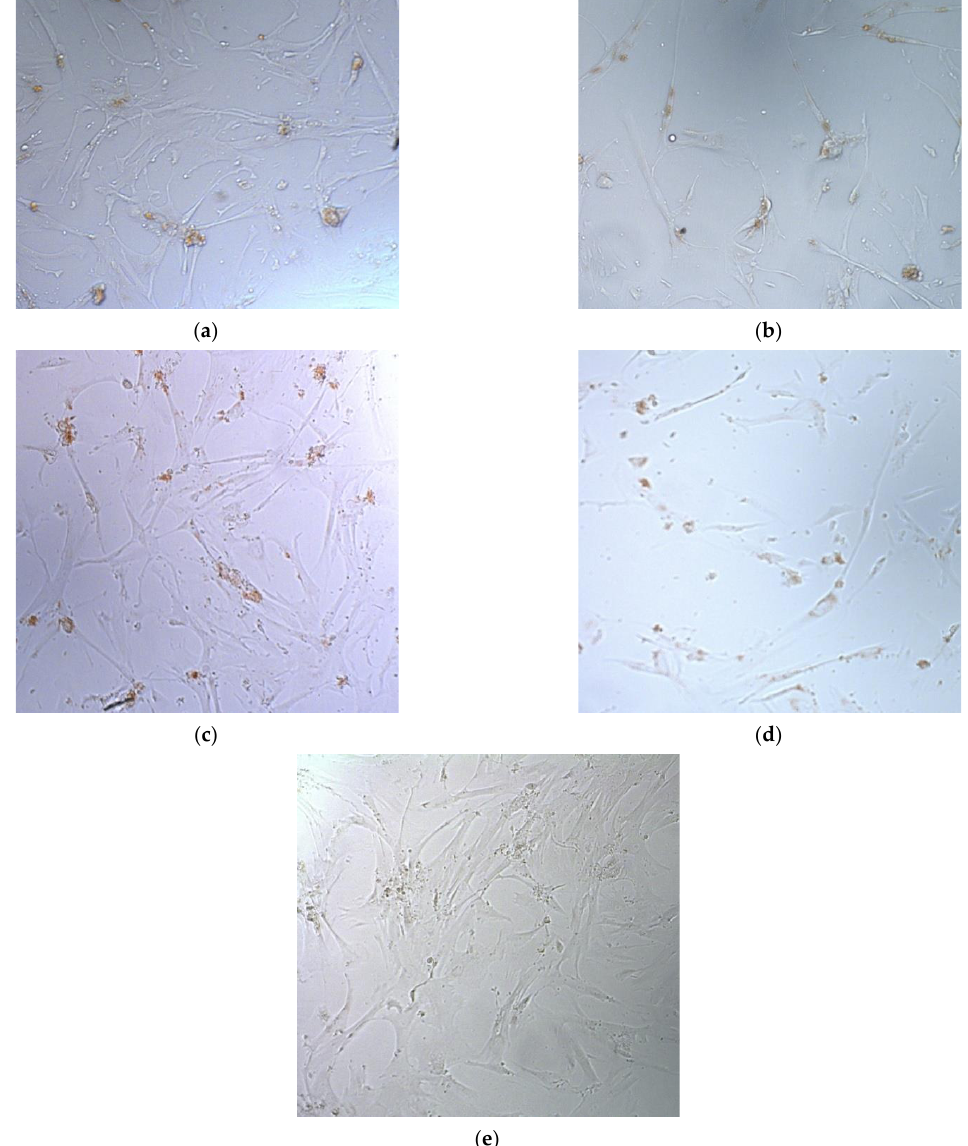
Figure 9. Typical micrographs in bright field conducted 96 h after GCV treatment. The UL cells were transfected with R6p-cRGD/pCMV-lacZ/MNPs polyplexes at N/P ratios of ( a ) 8/1, ( c ) 12/1; and with pPTK1/R6p-cRGD/MNPs polyplexes at ( b ) 8/1, ( d ) 12/1 charge ratio. Control wells contained ( e ) GCV-treated